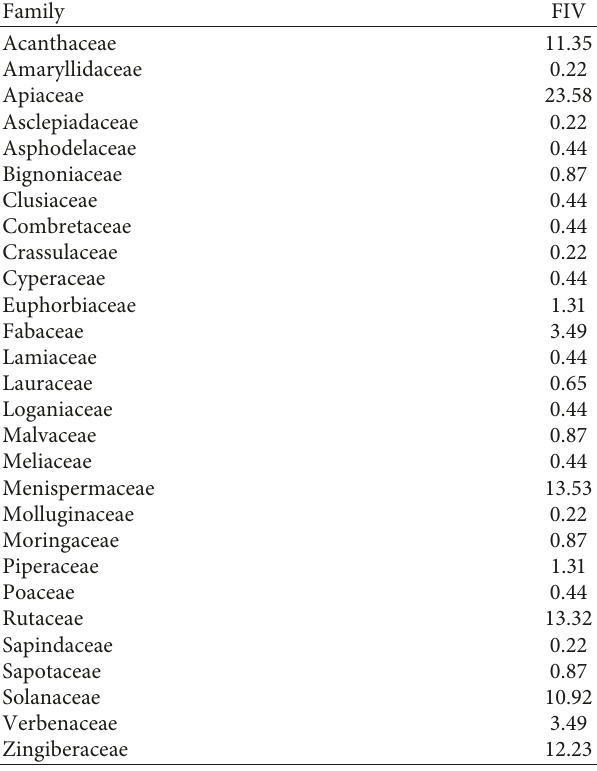
Table 1: Statistics on the usage of herbal therapeutics as anti-in- flammatory remedies.